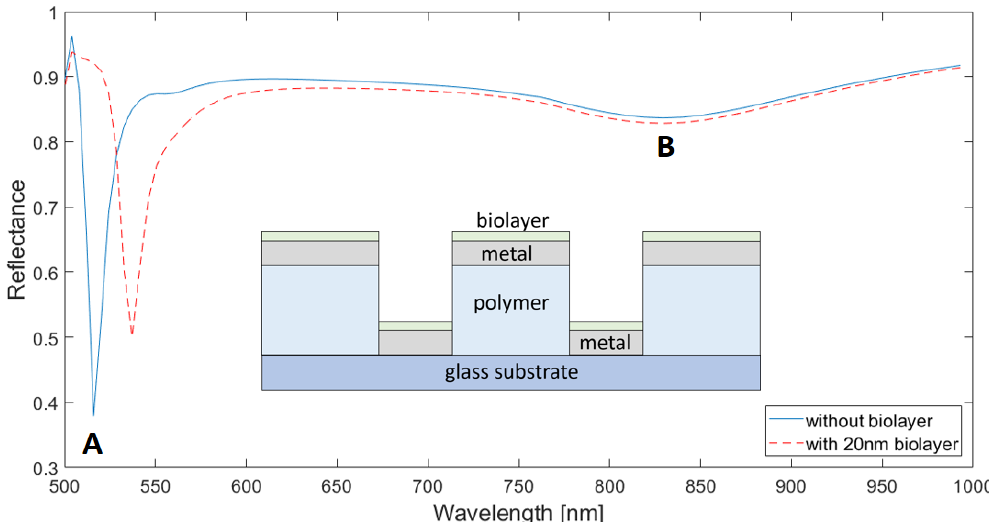
Figure 2. Reflectance spectra of a 500 nm period Al/polymer plasmonic 2D crystal (inset) for d = 150 nm and h = 150 nm. Al metal thickness is 100 nm. Blue and red (dotted) lines correspond to t bio = 0 and t bio = 20 nm, respectively. A and B indicate minima (dips) of the curve for t bio = 0.